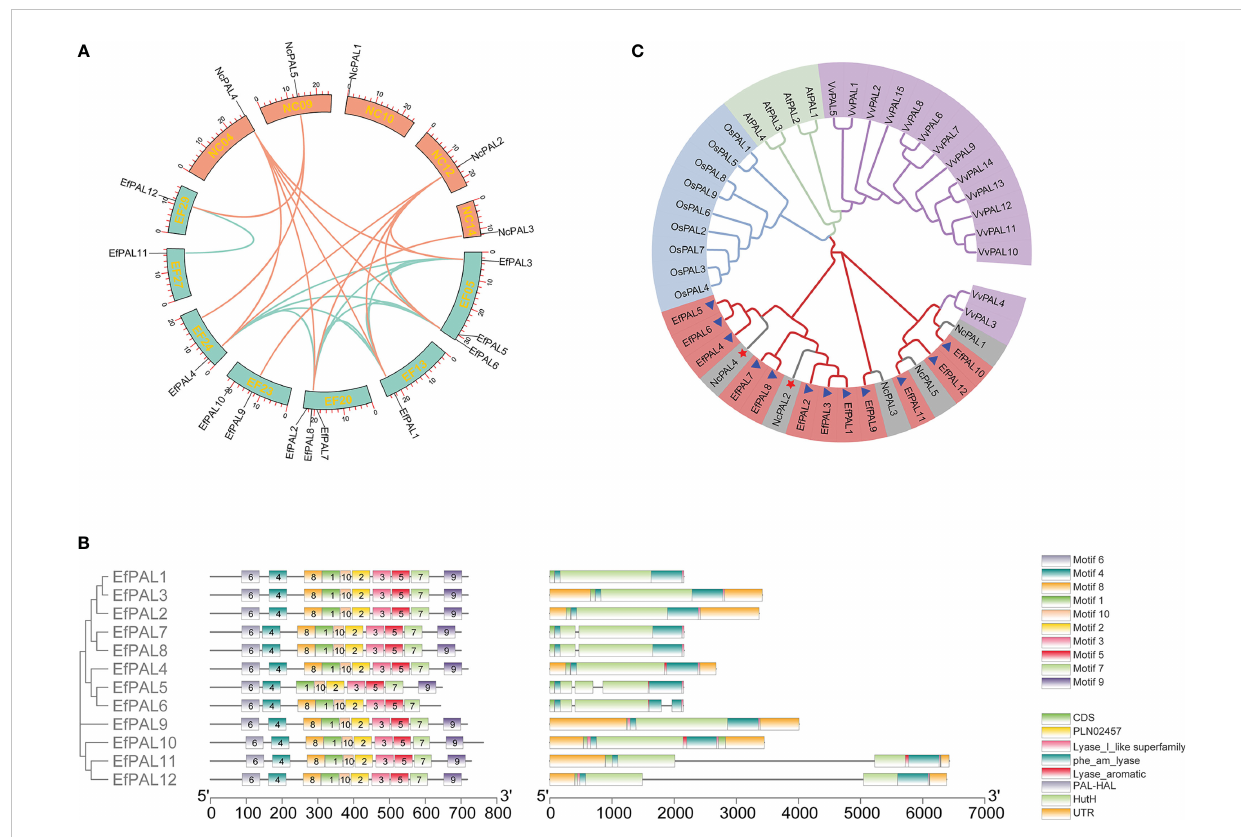
FIGURE 1 Microcollinearity analysis, motif distribution, conserved domains, gene structure, and phylogenetic analysis. (A) The micro-collinearity relationship of PAL in E. ferox and N. colorata . (B) Motif distribution, conserved domains and gene structure for the 12 putative PALs in E. ferox . (C) Phylogenetic tree of E. ferox PALs. Purple, green, blue, red and gray represent PALs from Vitis vinifera , Arabidopsis thaliana , Oryza sativa , E. ferox , and Nymphaea colorata , respectively.